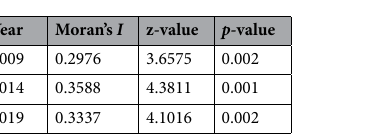
Figure 5. Distribution map of water ecological security status in 62 cities of the Yellow River Basin. Note This was created by ArcMap-GIS, version 10.5. https:// www. esri. com/.